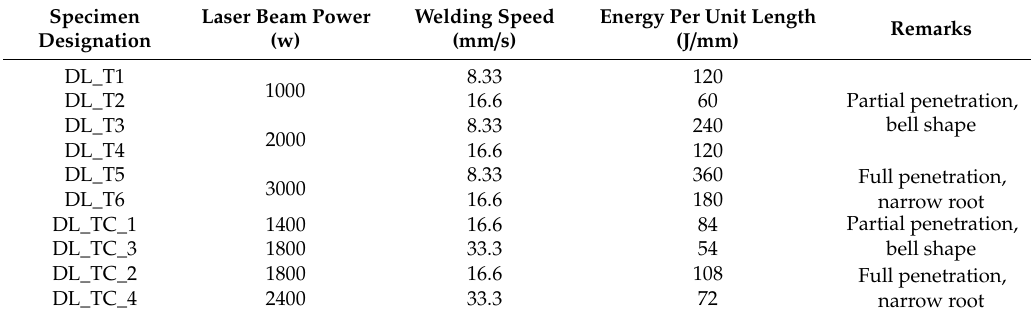
Table 3. Parameters of bead-on-plate laser welding of the 4.0- and 6.0-mm-thick AISI304 plates with the TRUMPF TruDisk 3302 laser.